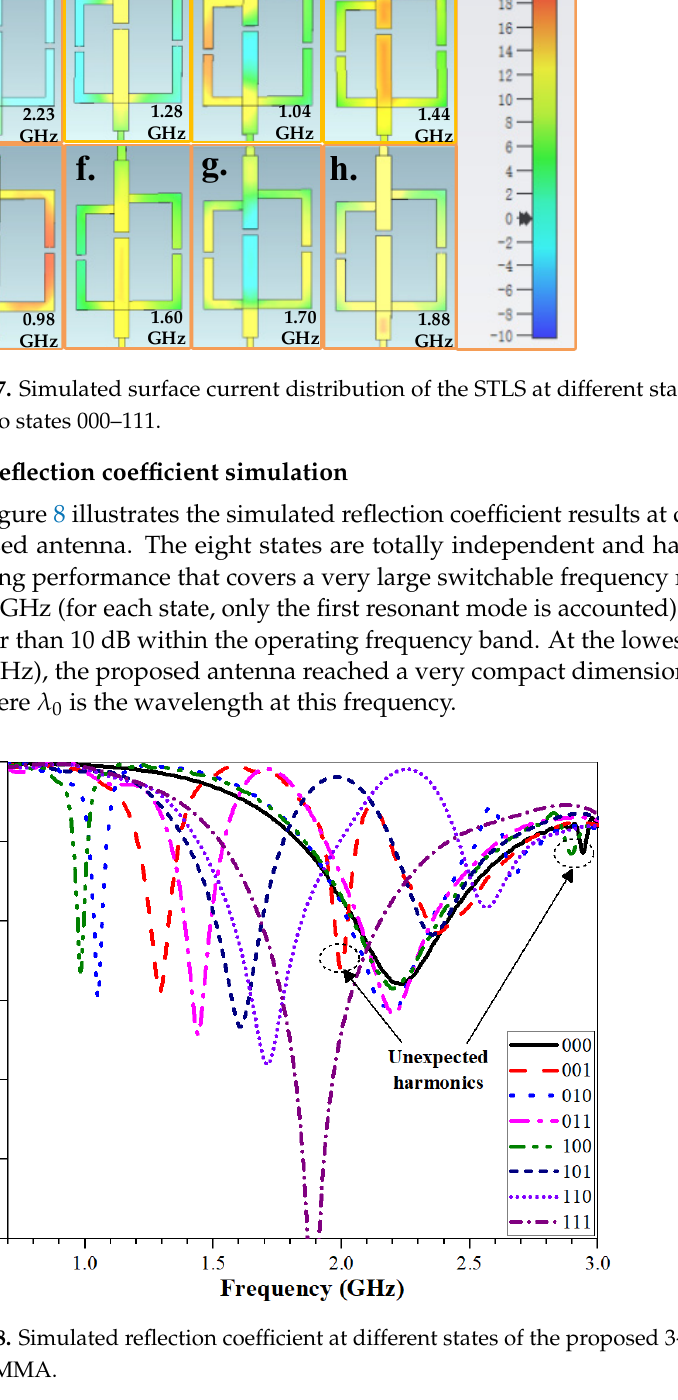
Figure 8. Simulated reflection coefficient at different states of the proposed 3-bit frequency recon- figurable MMA.